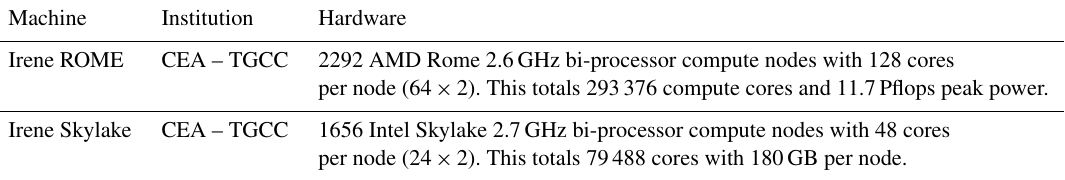
Table C1. Joliot-Curie supercomputer. Characteristics corresponding with the two partitions available in this